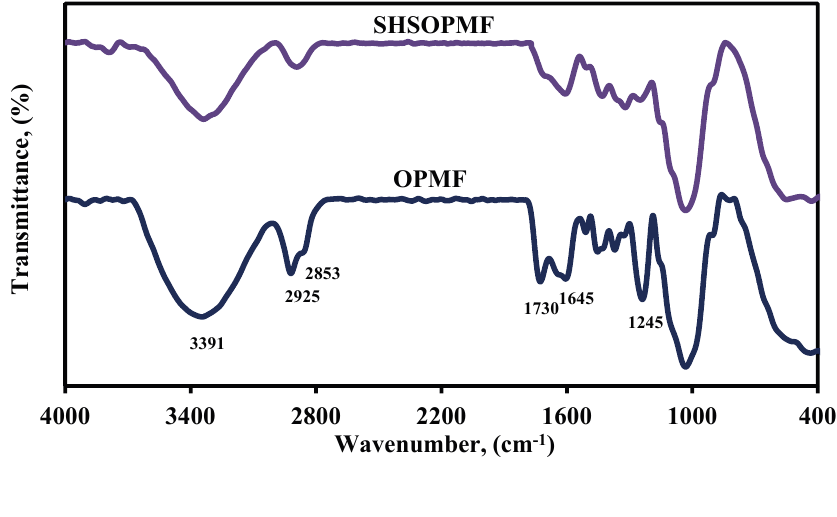
Figure 1. FTIR spectra of OPMF and SHSOPMF.